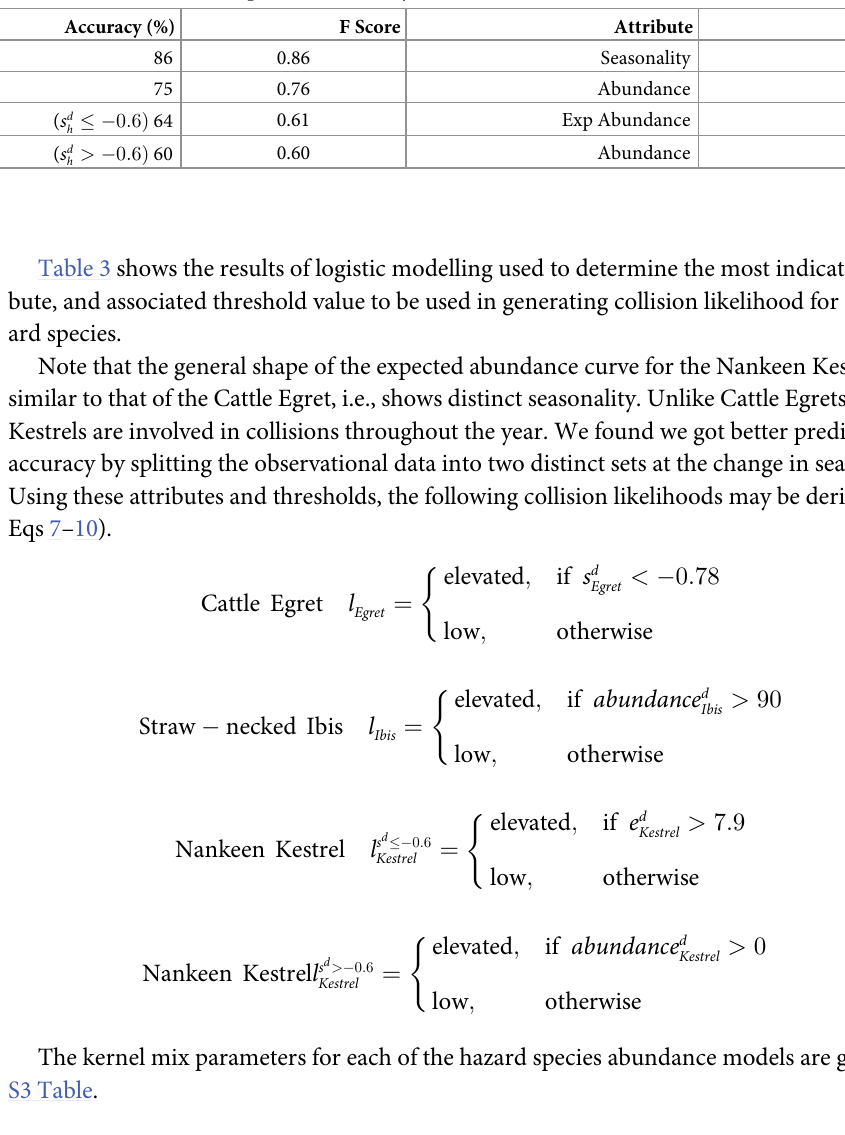
Table 3. Logistic regression modelling results for each of the three hazard species showing model quality (accuracy and F Score), attribute with highest feature importance in the model, and threshold value that maximises strike likelihood prediction